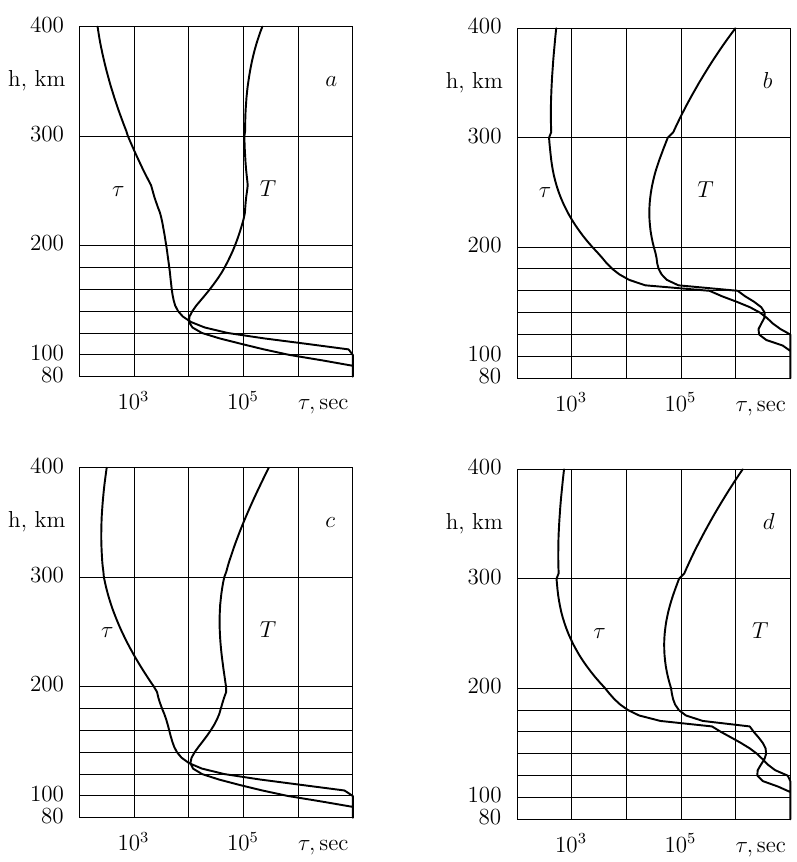
Fig. 1. Vertical cross-sections of the time parameters τ and T . The panels (a) , (b) correspond to θ m = 90 ◦ , (c) , (d) correspond to θ m = 45 ◦ . The left and right columns present midday and midnight values,